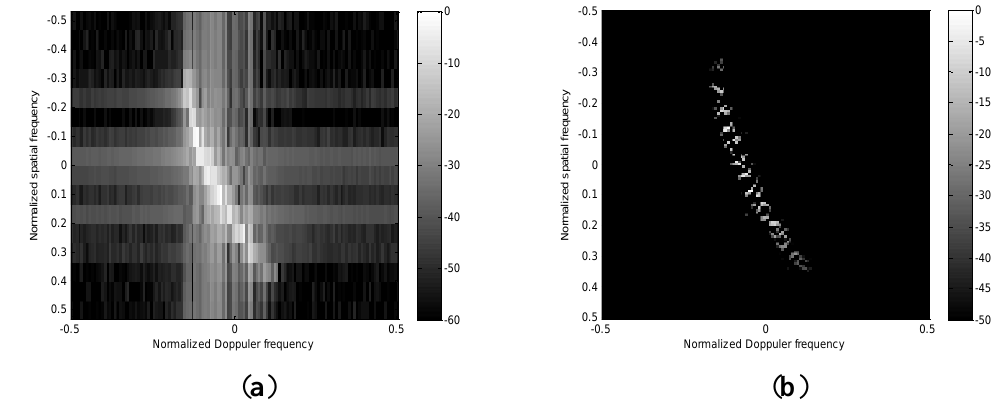
Figure 4. The clutter angle-Doppler spectrum image with a 10.5 km slant distance. ( a ) 2D FFT; ( b ) Spatial